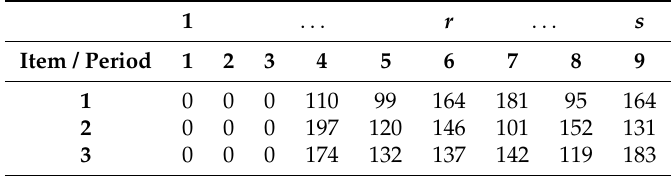
Table 2. Demand per item and per period for the shifted planing